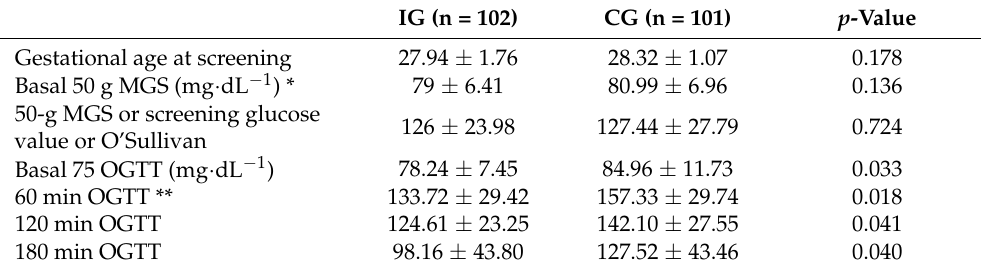
Table 3. Glucose values for the 50g OGTT and 75 g OGTT between IG and CG.